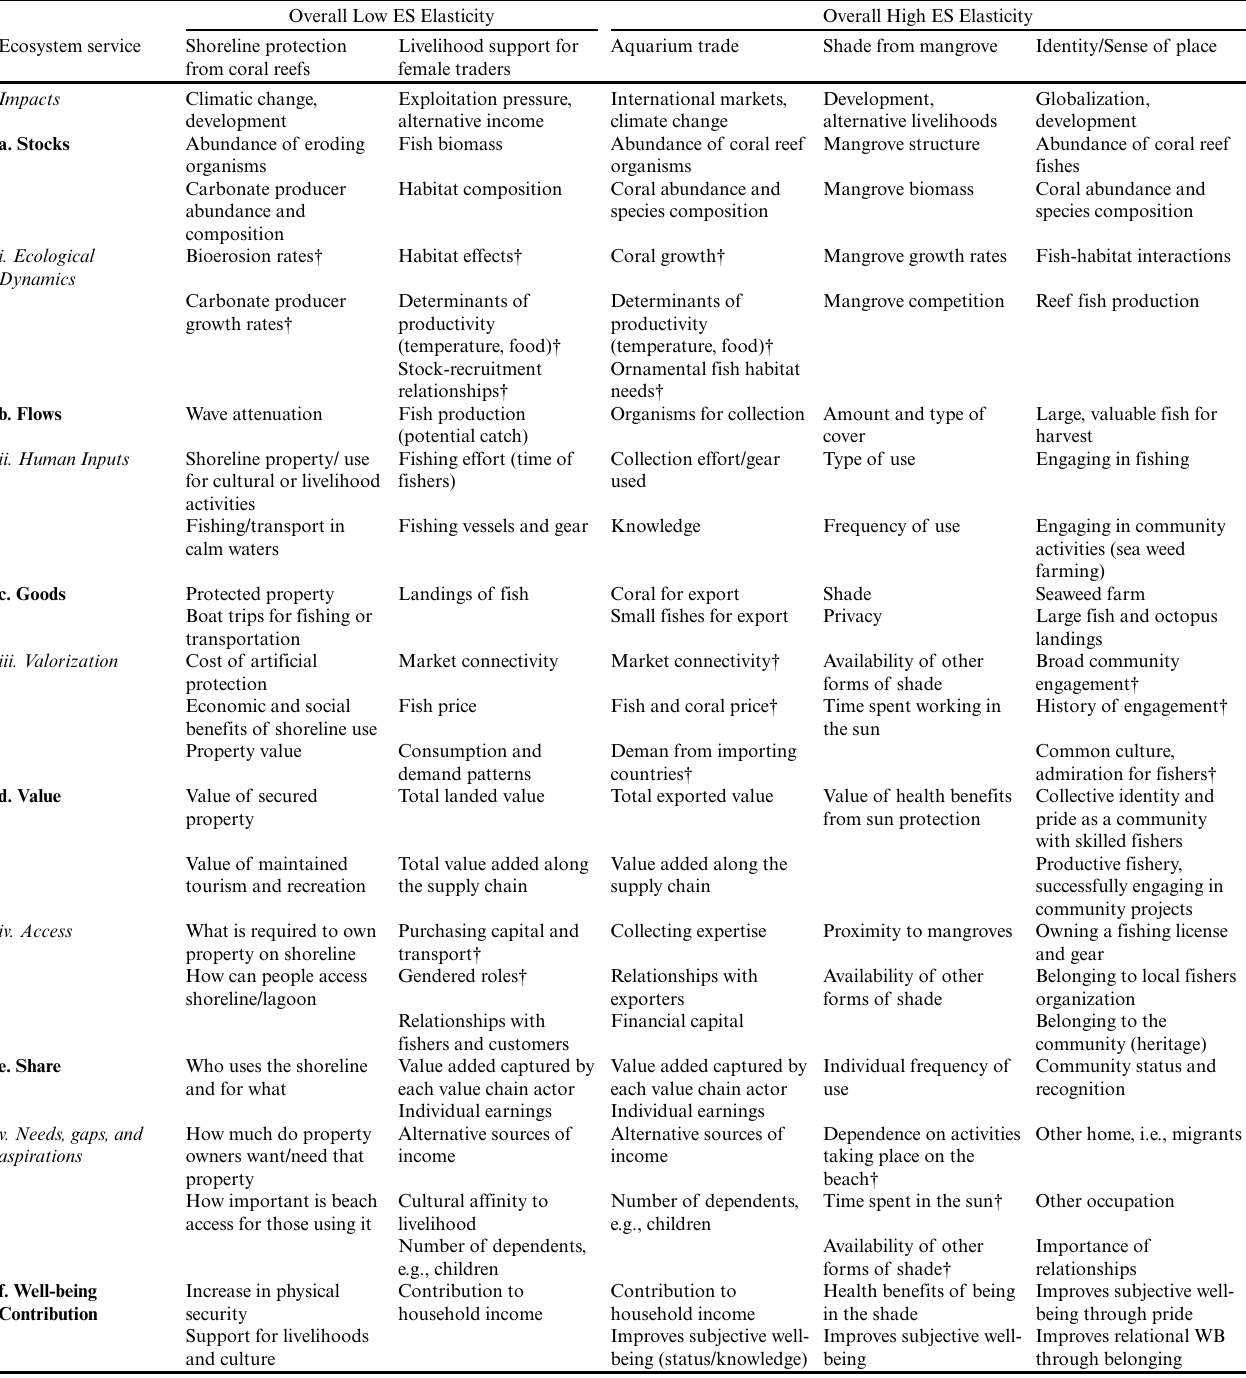
Table 2 . Five coastal ecosystem services from East Africa (see Box 1) mapped out using the chain framework, with examples of low and high ES elasticity deriving from different parts of each chain. Multipliers contributing to low or high overall ES elasticity are marked with